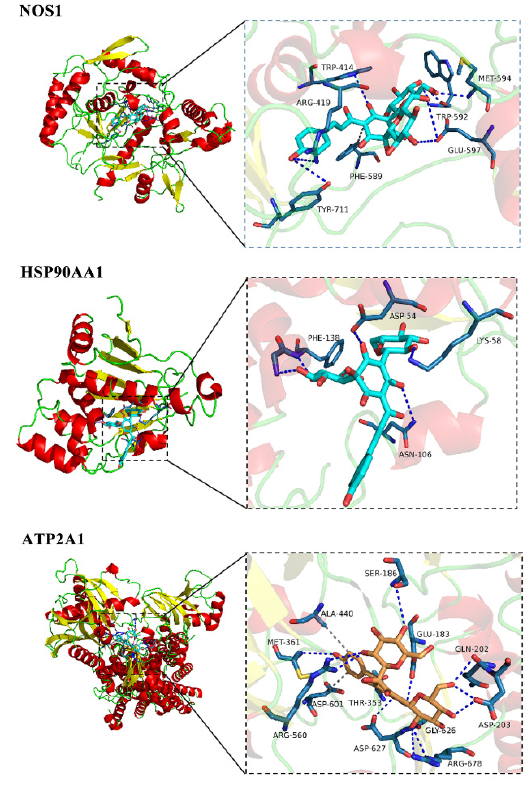
Figure 8. Docking results of HSYA with the